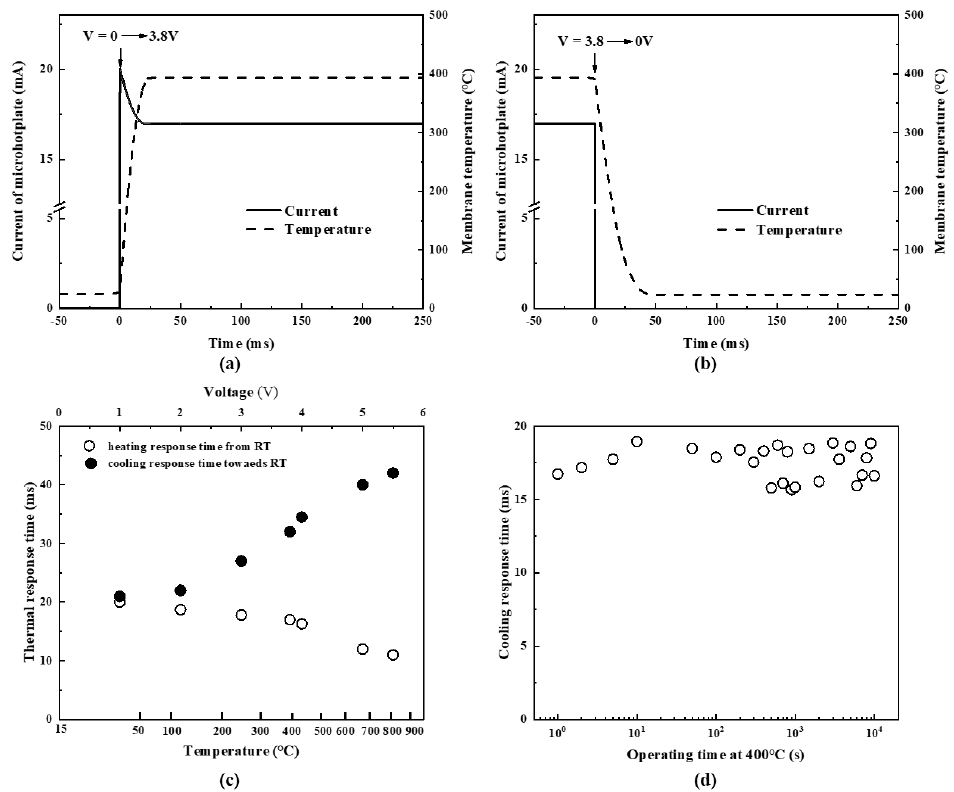
Figure 10. Thermal response characteristic: ( a ) heating from room temperature to 400 °C; ( b ) cooling from 400 °C to room temperature; ( c ) heating and cooling response time with sweeping voltage; ( d ) cooling response time while operating at 400 °C for an hour.